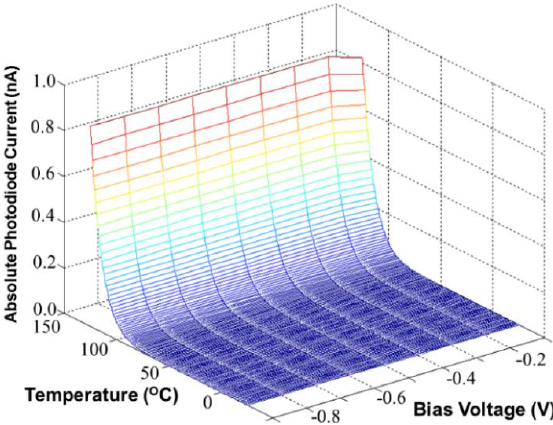
Figure 3. Simulated PD dark currents versus the environmental temperature (°C) and bias voltage (V) in dark conditions.